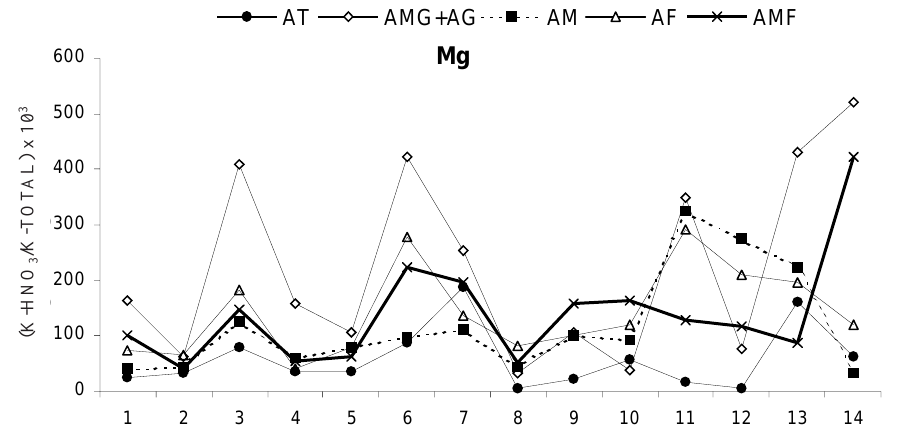
Figura 5. Relação entre Mg extraído pelo HNO 1 mol L -1 (K não-trocável) e pelos ácidos: fluorídrico, 3 nítrico e sulfúrico (HF) (K total) na areia total (AT) e nas subdivisões da areia leve (AMG + AG-areia muito grossa + areia grossa, AM-areia média, AF-areia fina e AMF-areia muito fina). Quadro 5. Teores de K e Mg extraídos com HNO 1 mol L -1 fervente da fração areia e de suas subdivisões 3